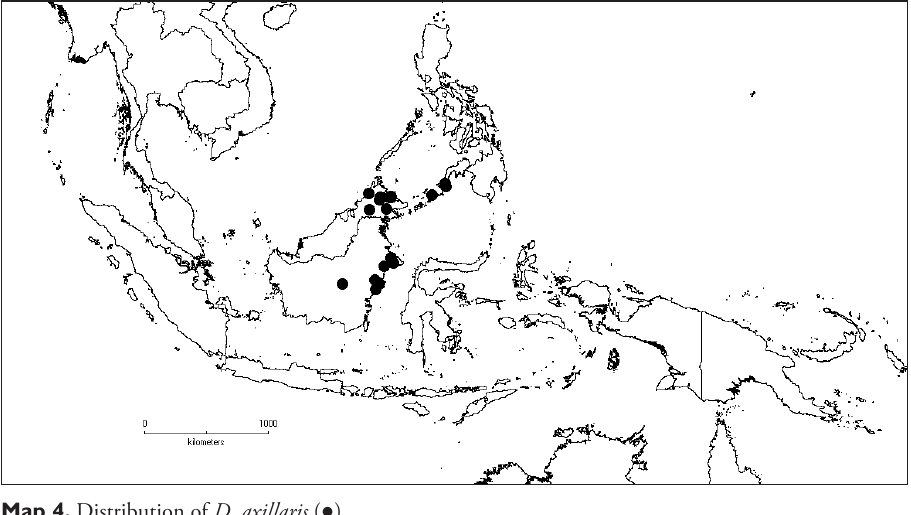
Map 4. Distribution of D. axillaris ( ● ).